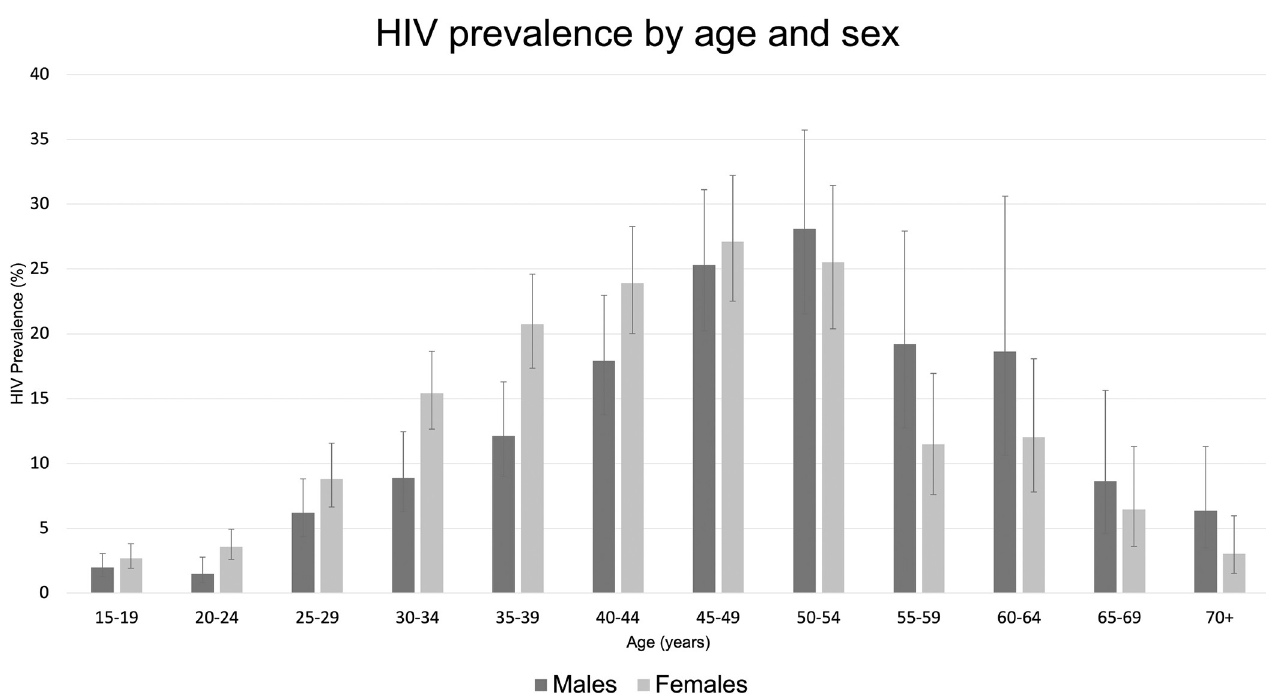
Fig 2. Breakdown of weighted HIV seroprevalence across socio-demographic characteristics. Error bars represent 95% CI.